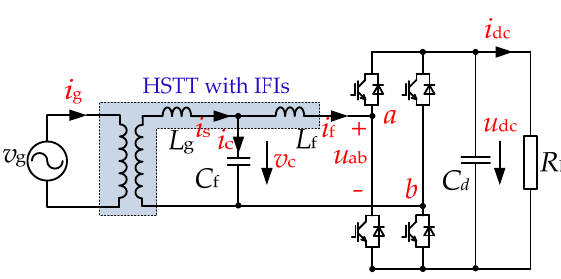
Figure 2. Diagram of single-phase grid-side converters with an LCL-type filter.